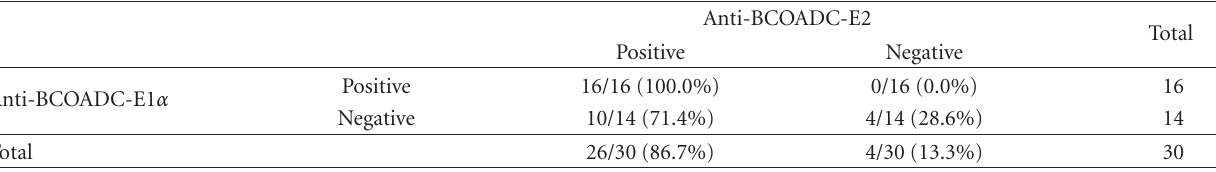
Table 1: Number of patients with and without anti-BCOADC-E1 α and anti-BCOADC-E2